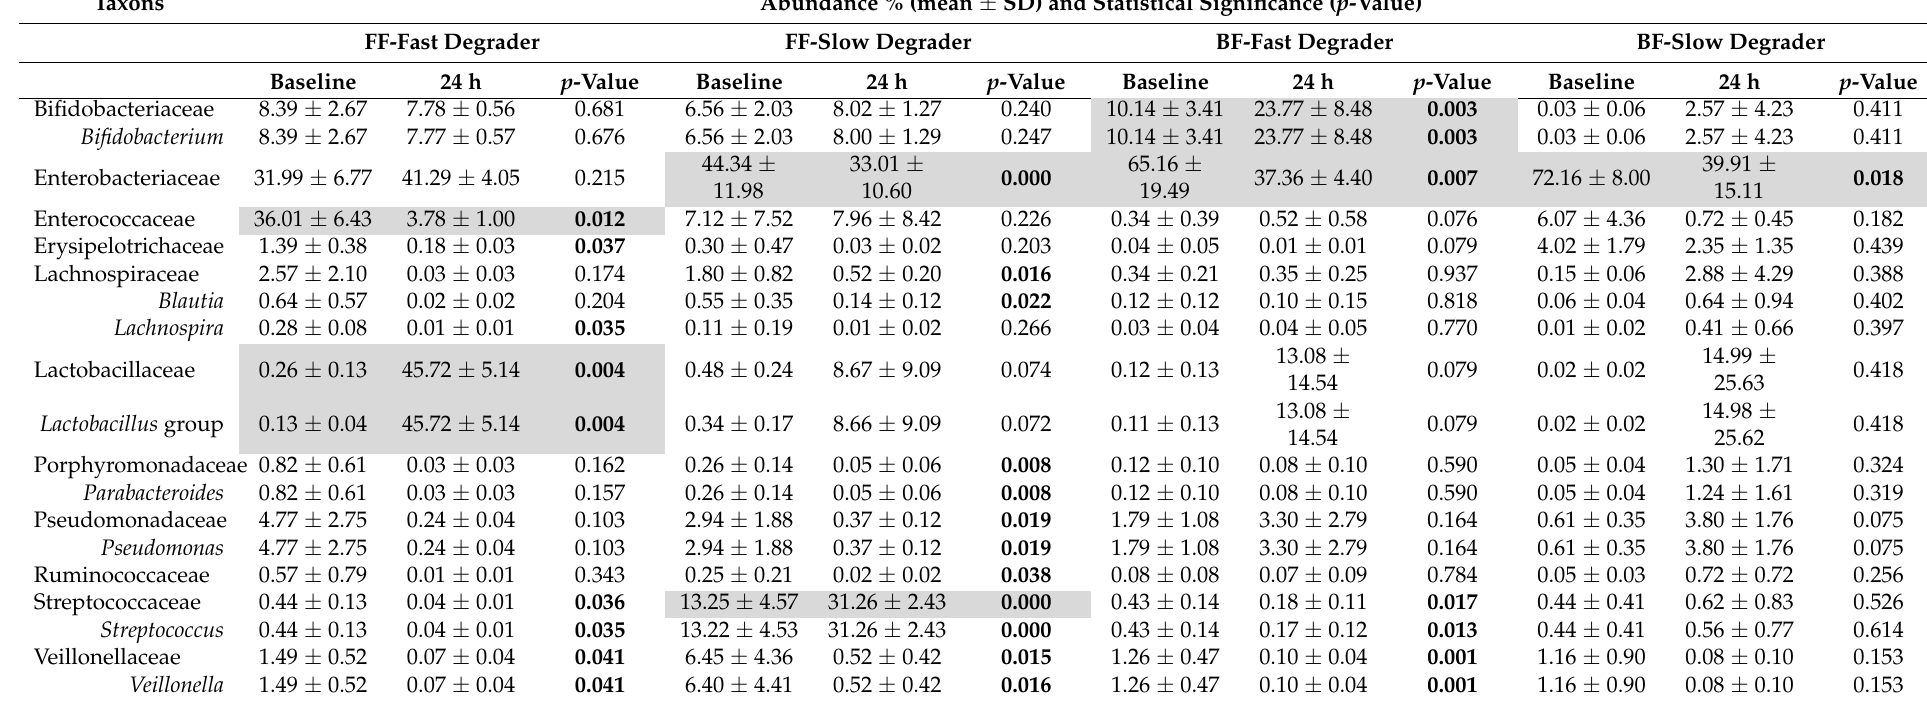
Table 1. Family and genus-level of the most abundant taxa (relative abundance >1% in any of the two taxonomic levels at 0 and/or 24 h of incubation for any of the inocula groups) displaying significant changes during incubation in the presence of 2 (cid:48) FL for the four fecal culture classification groups defined in this study: FF-fast degrader, FF-slow degraders, BF-fast degraders, BF-slow degrader. Relative abundances were compared at baseline and after 24 h of incubation. Significant differences are highlighted in bold ( p -value < 0.05). Gray shaded cells show relevant changes for the most abundant taxa in each fecal